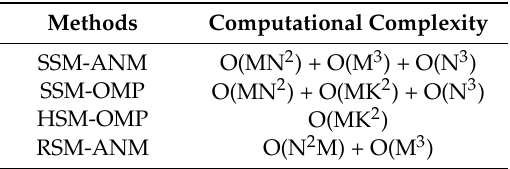
Table 5. Computational complexity of different